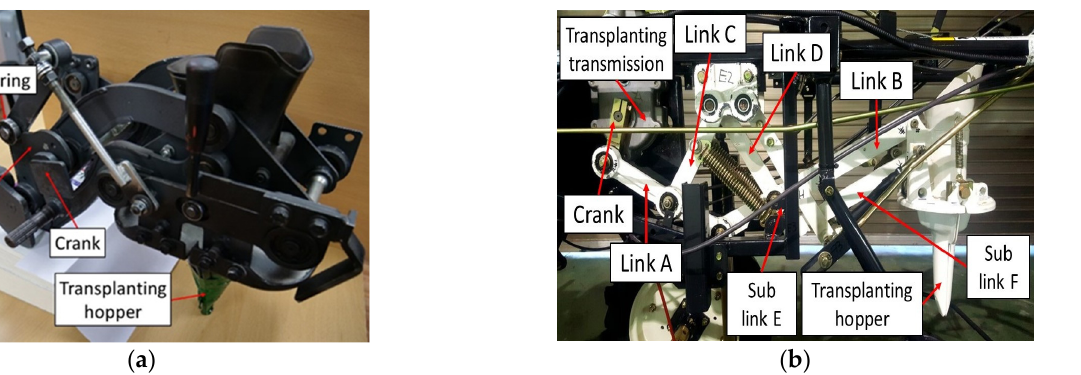
Figure 3. Shapes of the transplanting devices of the semi-automatic vegetable transplanter types: ( a ) cam and ( b ) four-bar link.